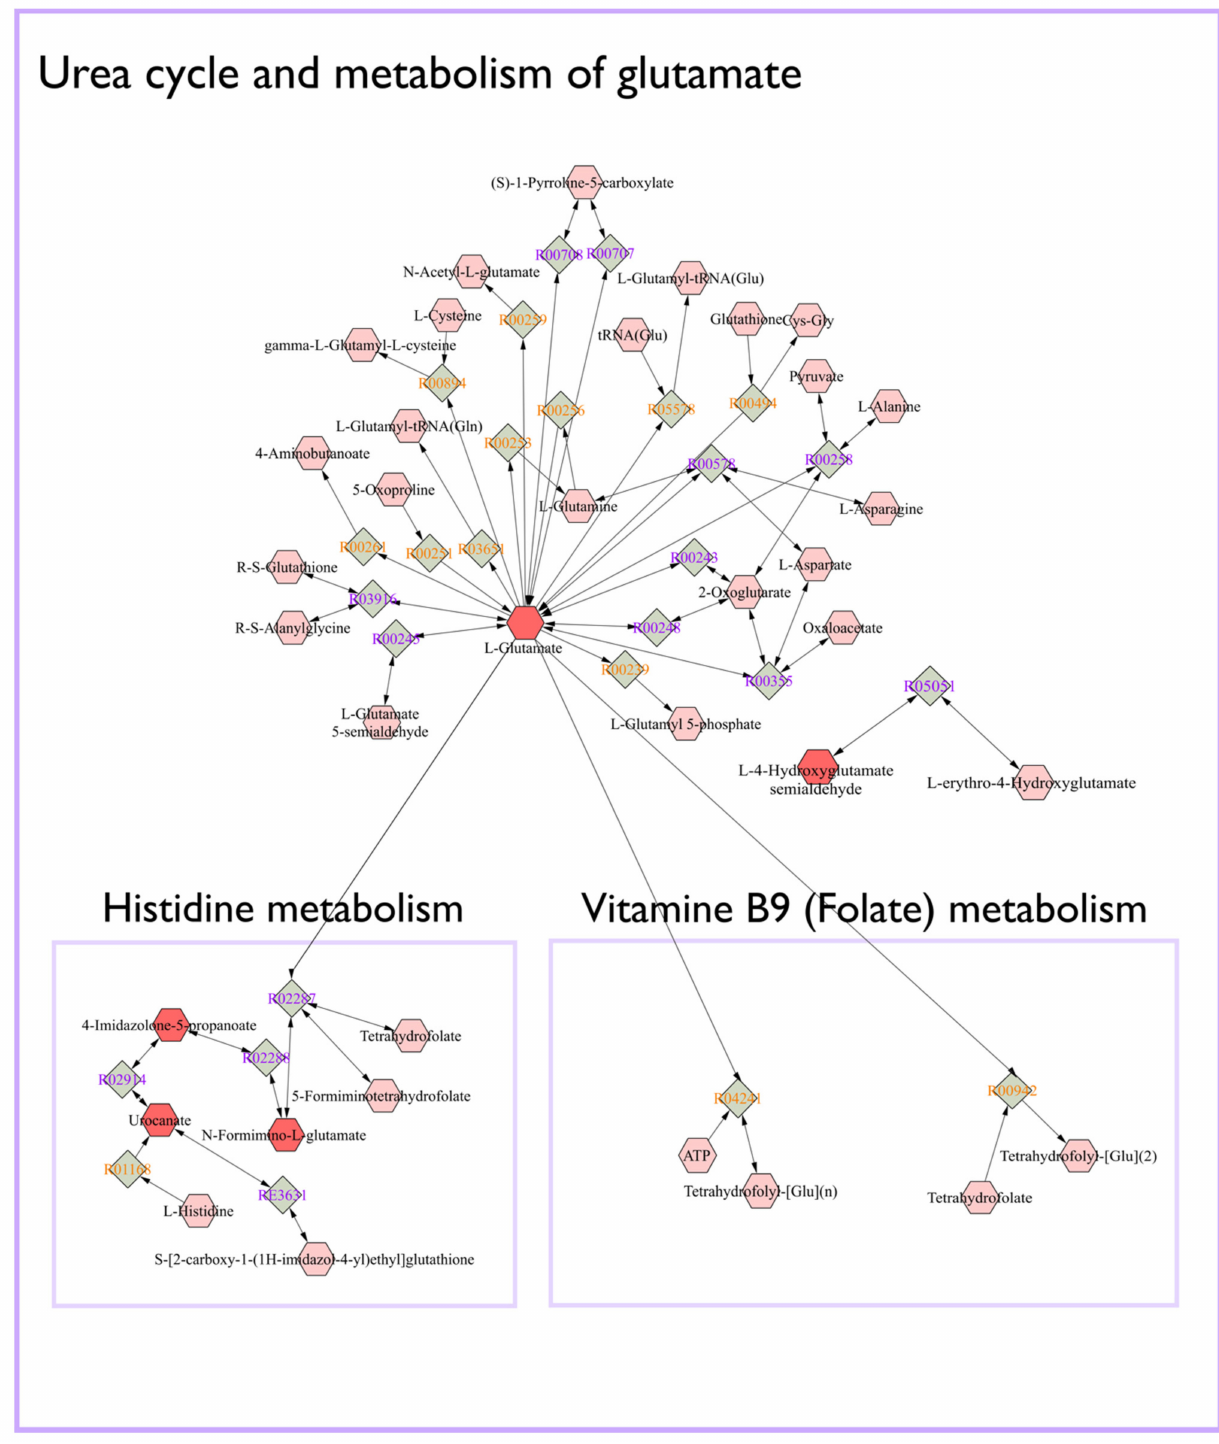
Figure 4. Connected networks of metabolites in the significant pathways based on the KEGG database. The nodes in red indicated differential metabolites that could be measured in this